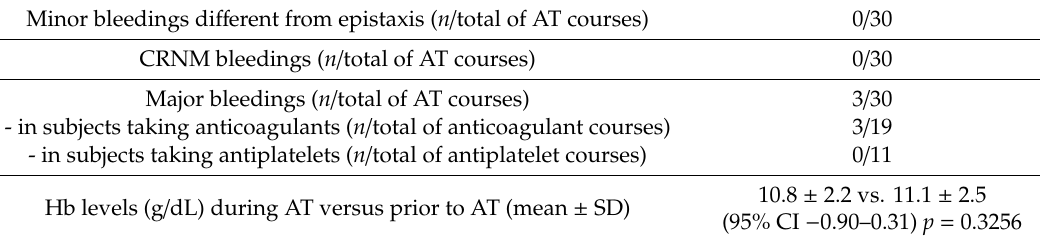
Table 4. Bleeding complications during AT.